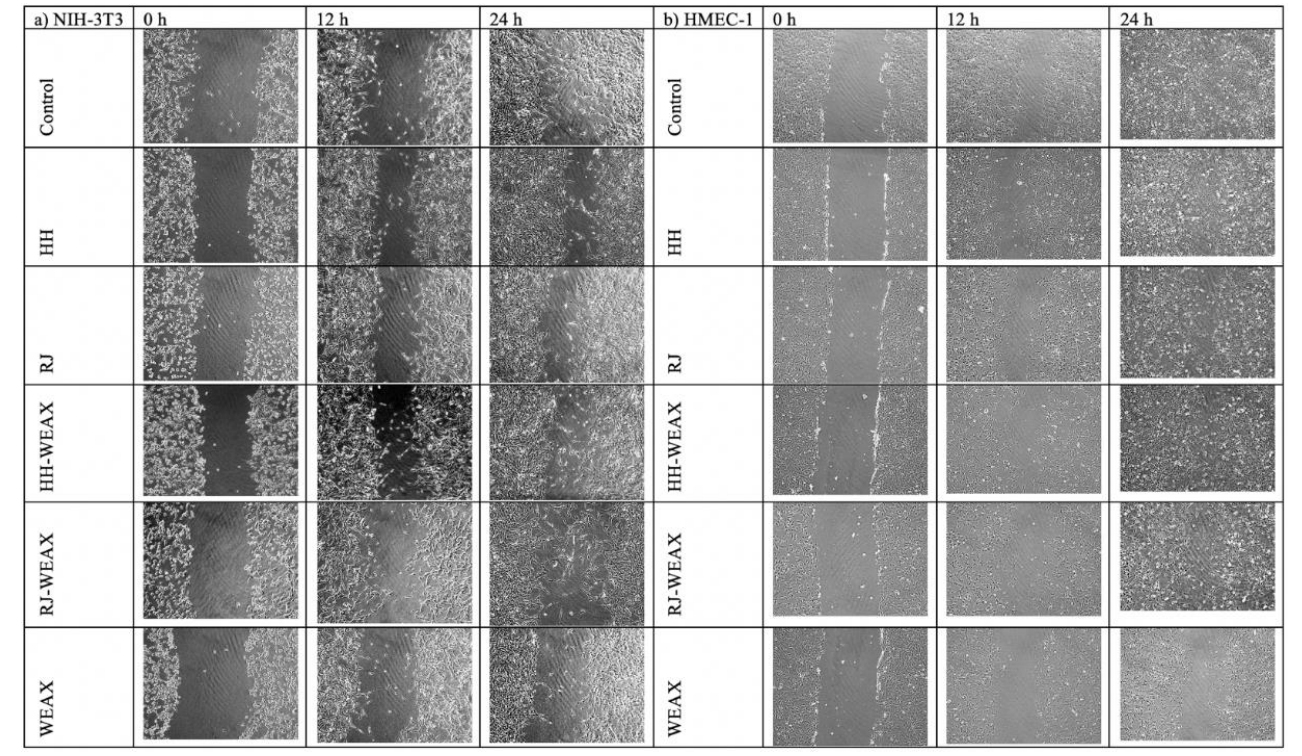
Figure 5. Assessment of the migration rate of ( a ) NIH-3T3 and ( b ) HMEC-1 cells for the HH-WEAX microcapsules at 0.15 mg mL −1 concentration in comparison to the control sample; 400× magnification.